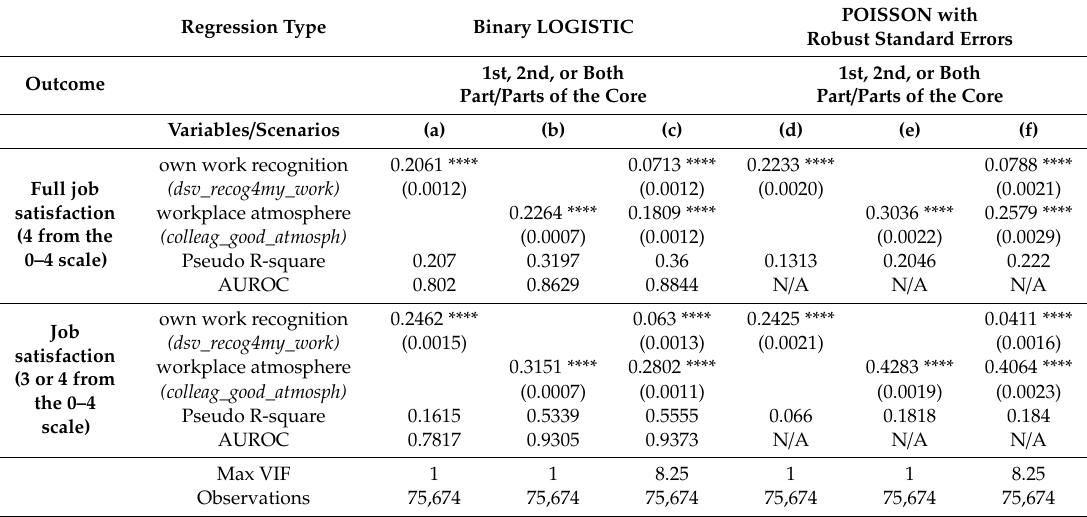
Table 4. Testing the strongest influences (dual-core) for a European model of predicting job satisfaction in terms of average marginal e ff ects by following the same balanced approach of treating missing values (0 to 4 scale, where 2 is an additional distinct level for missing, undecided answers and unwillingness to respond).